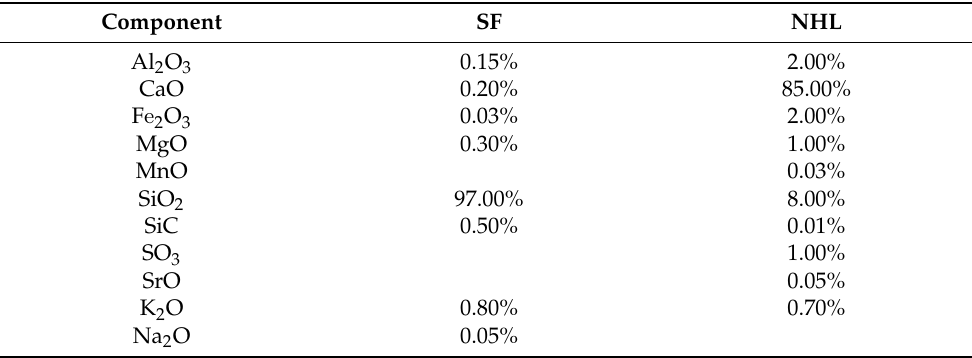
Table 1. Chemical properties of NHL and